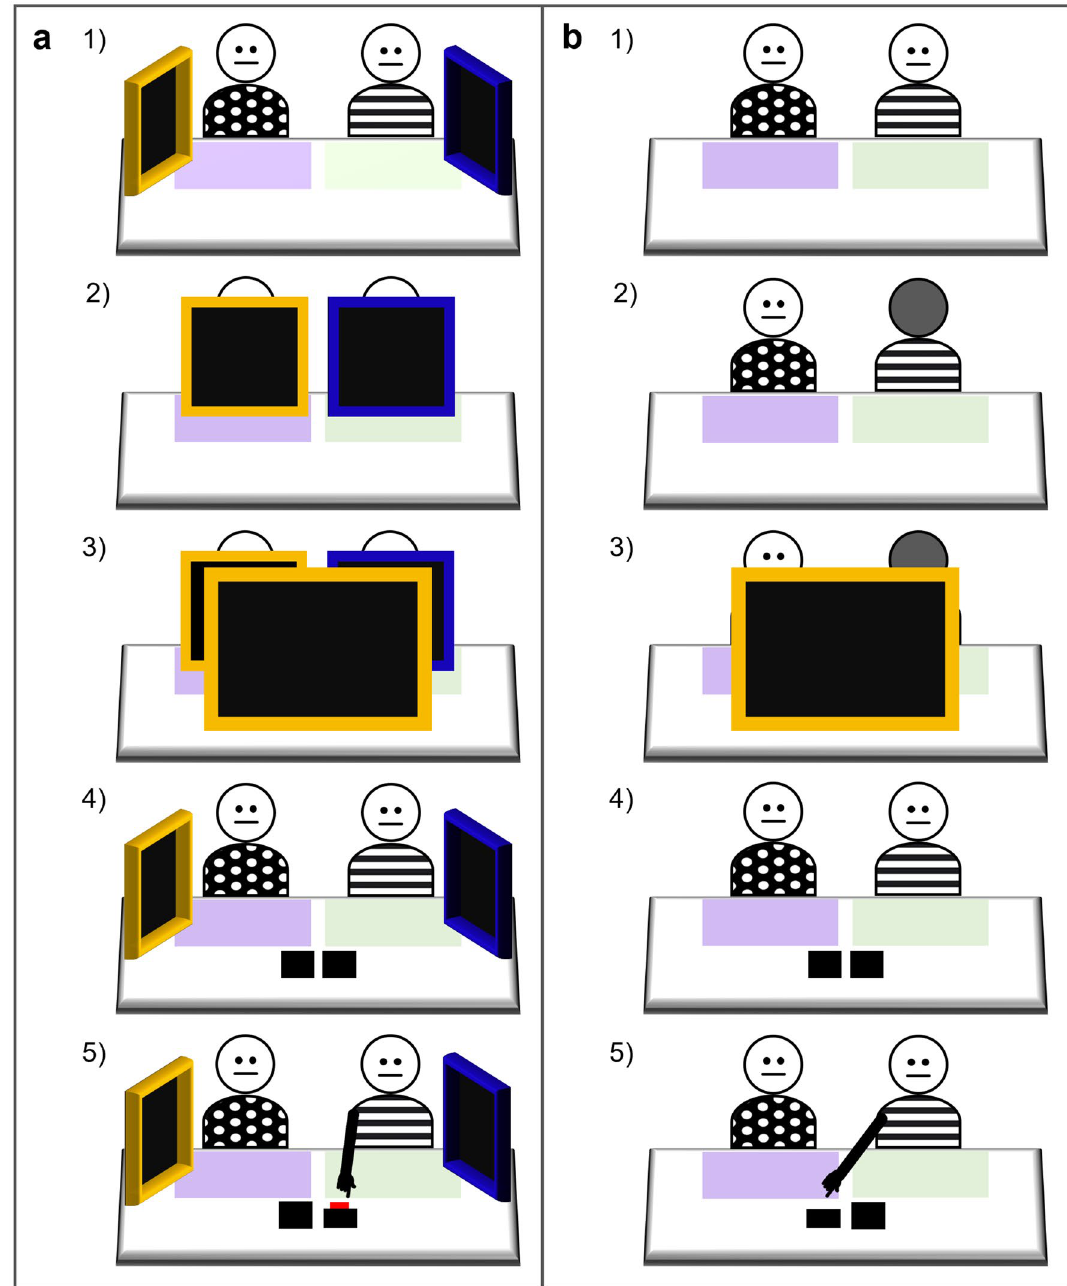
Figure 5. Schematic illustration from the perspective of the participant, including placement of frames and boxes. ( a ) example of trials in which perceptual access is indicated by opaque (yellow) and semi-opaque (blue) screens, as in all pre-switch trials and the first three switch trials; ( b ) example of trials in which perceptual access is indicated by the informants facing or not facing the critical event (i.e., the ignorant informant faced away), as in the final two switch trials. The stages illustrated are: ( 1 ) start of the trial, ( 2a ) screens placed in front of informants, ( b ) ignorant informant turns away, ( 3 ) opaque (yellow) screen occludes participant’s view, behind the screen two boxes (one containing Lego) are mixed around and closed, ( 4a ) screens removed, ( b ) ignorant informant turns back around, ( 5 ) participant selects informant, reward revealed or not revealed depending on phase and